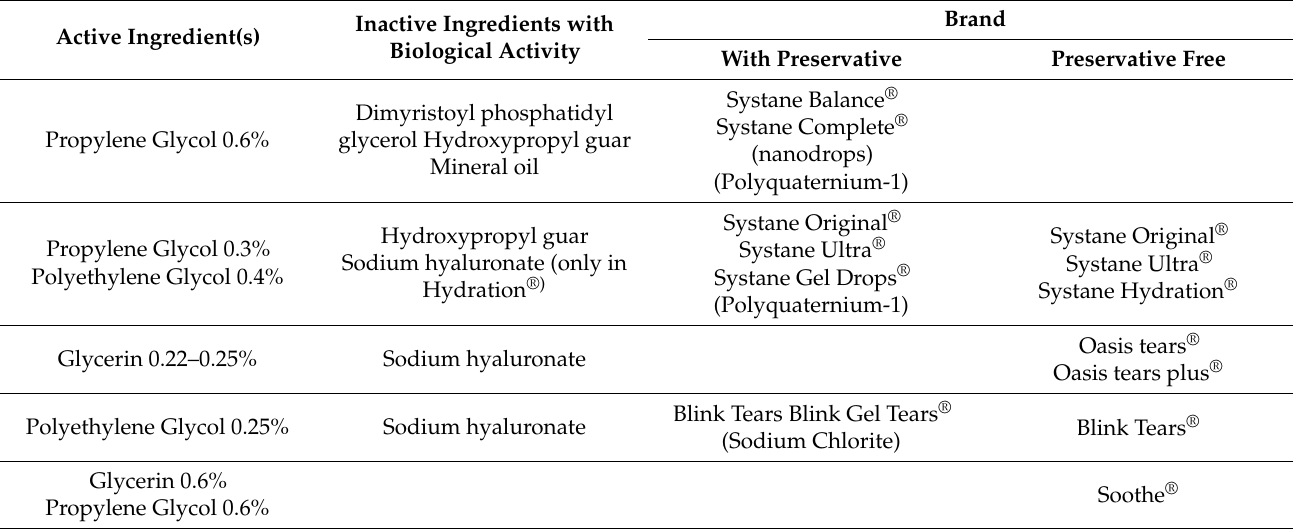
Table 3. Artificial tears containing propylene glycol, polyethylene glycol, and glycerin as demulcents.